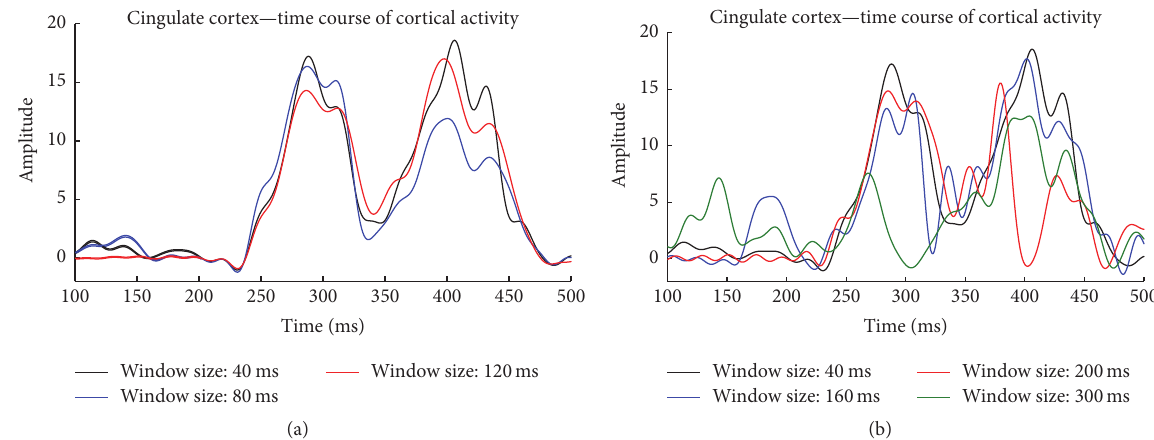
Figure 6: Cortical activity of the cingulate cortex calculated with different window sizes. Results with smaller window sizes show a great similarity (correlation 𝑅 > 0.95) in (a); and results with larger window sizes show a greater disparity (correlation 𝑅 < 0.7) in